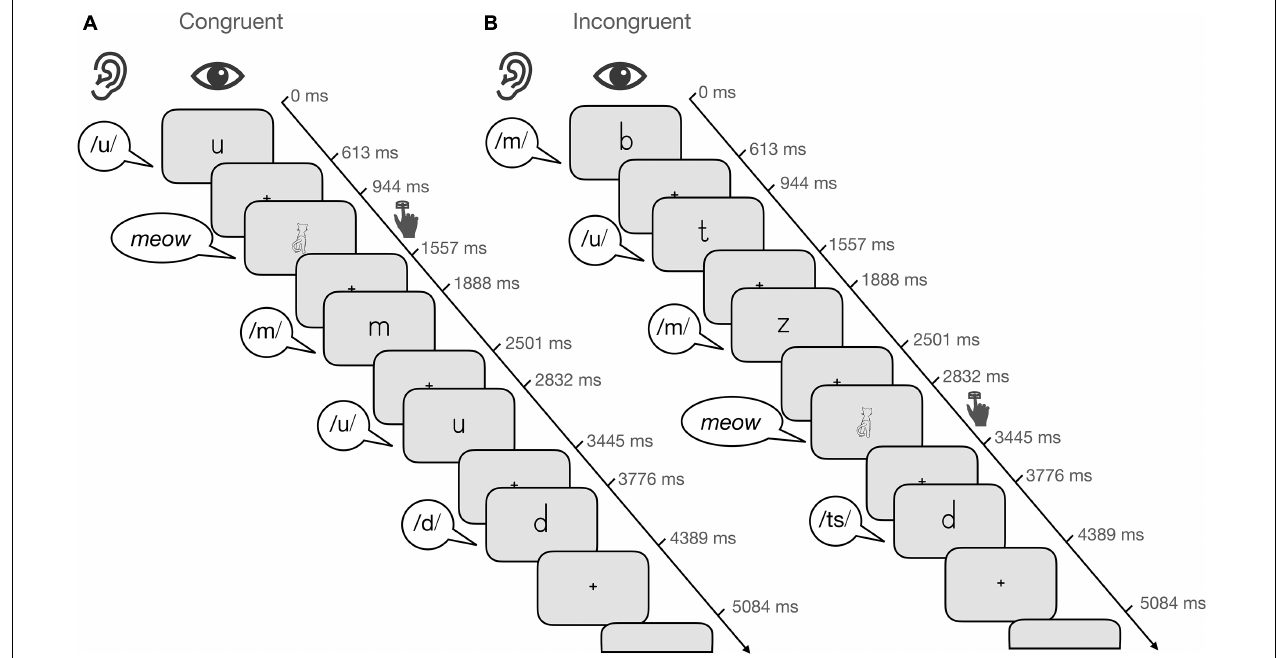
FIGURE 1 | Audiovisual target detection task. Illustration of five trials for (A) the audiovisual congruent condition and (B) the audiovisual incongruent condition. Each block consisted of 15 trials that were presented pseudorandomly for 613 ms with an interstimulus interval of 331 or 695 ms. Participants were instructed to respond when the target, i.e., the drawing of a cat